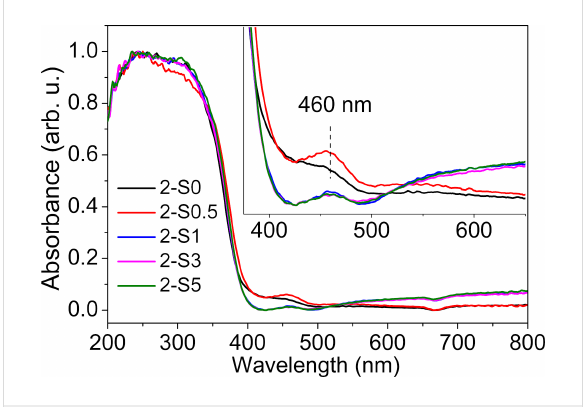
Figure 6: The UV–vis DRS of 2-S0, 2-S0.5, 2-S1, 2-S3 and 2-S5. The inset is the magnified plot of the UV–vis DRS in the visible light region.